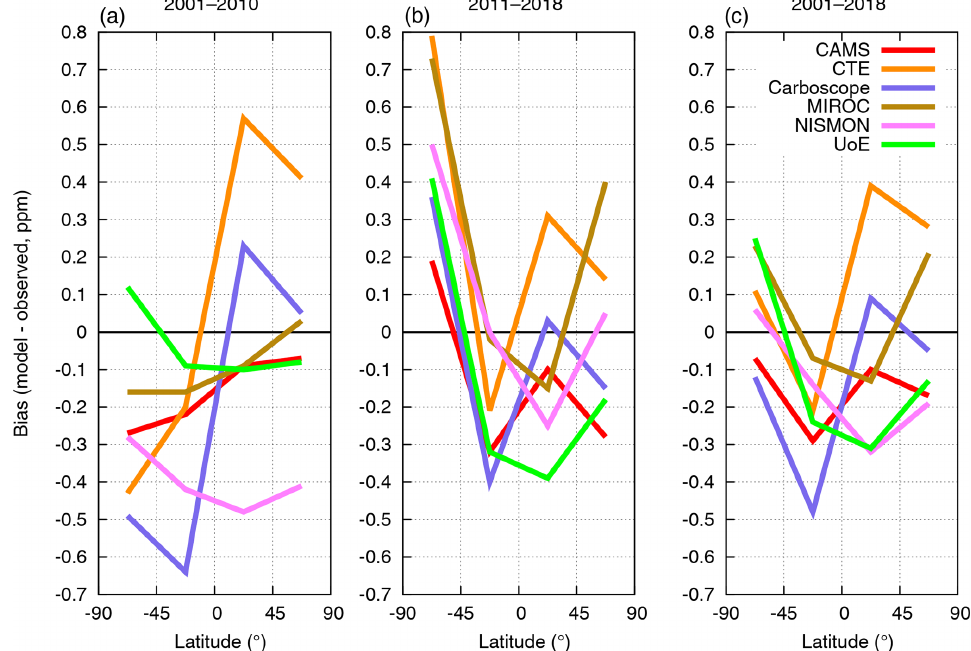
Figure B3. Evaluation of the atmospheric inversion products. The mean of the model minus observations is shown for four latitude bands in three periods: (a) 2001–2010, (b) 2011–2018, (c) 2001–2018. The four models are compared to independent CO 2 measurements made on board aircraft over many places of the world between 2 and 7km above sea level. Aircraft measurements archived in the Cooperative Global Atmospheric Data Integration Project (CGADIP, 2020) from sites, campaigns or programs that cover at least 9 months between 2001 and 2018, and that have not been assimilated have been used to compute the biases of the differences in four 45 ◦ latitude bins. Land and ocean data are used without